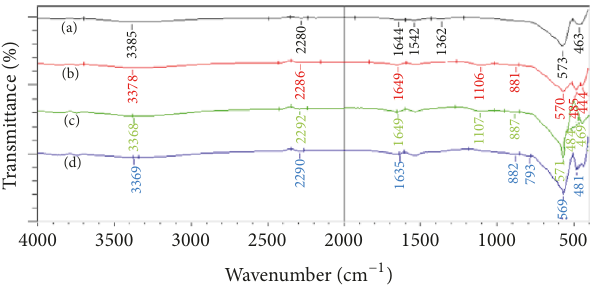
Figure 3: FT-IR spectra of the zirconium-based ferromagnetic sorbent (a) before and after sorption of (b) Cu 2+ , (c) Zn 2+ , and (d) Cd 2+ [experimental conditions: sorbent dosage = 1g/L, initial concentration = 200 mg/L, and contact time = 24 h].